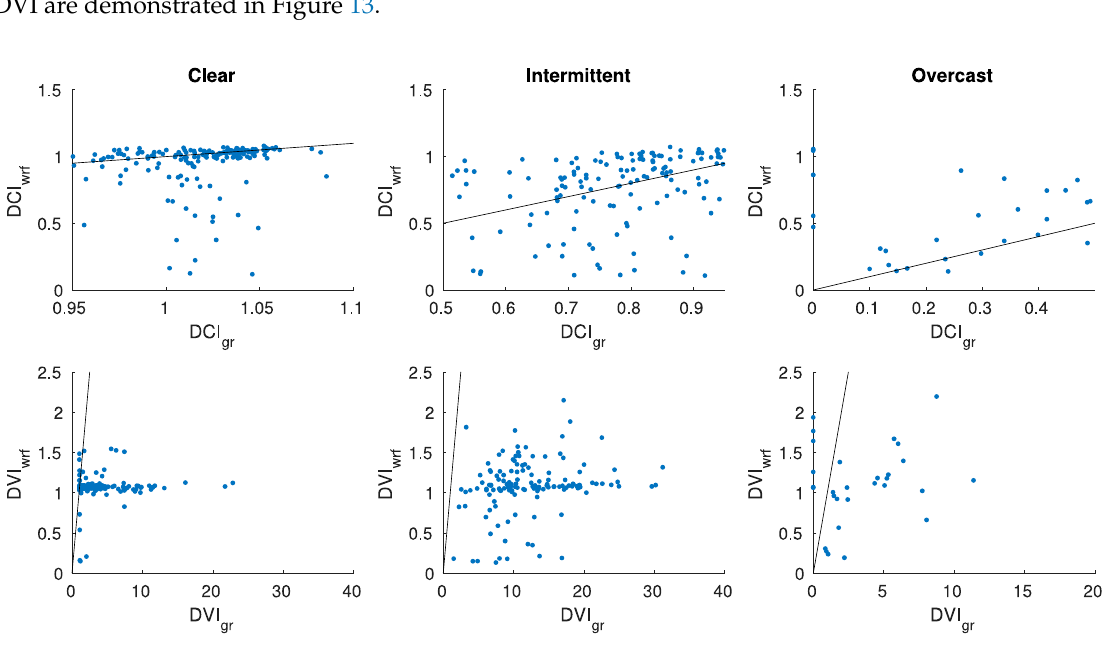
Figure 13. Scatterplots of measured and modelled daily clearness index ( DCI ) ( top ) and daily variability index ( DVI ) ( bottom ) using WRF-Solar at 45 km grid spacing for clear ( left ), intermittent ( centre ), and overcast ( right ) cases. The line of agreement for reference is shown in black.